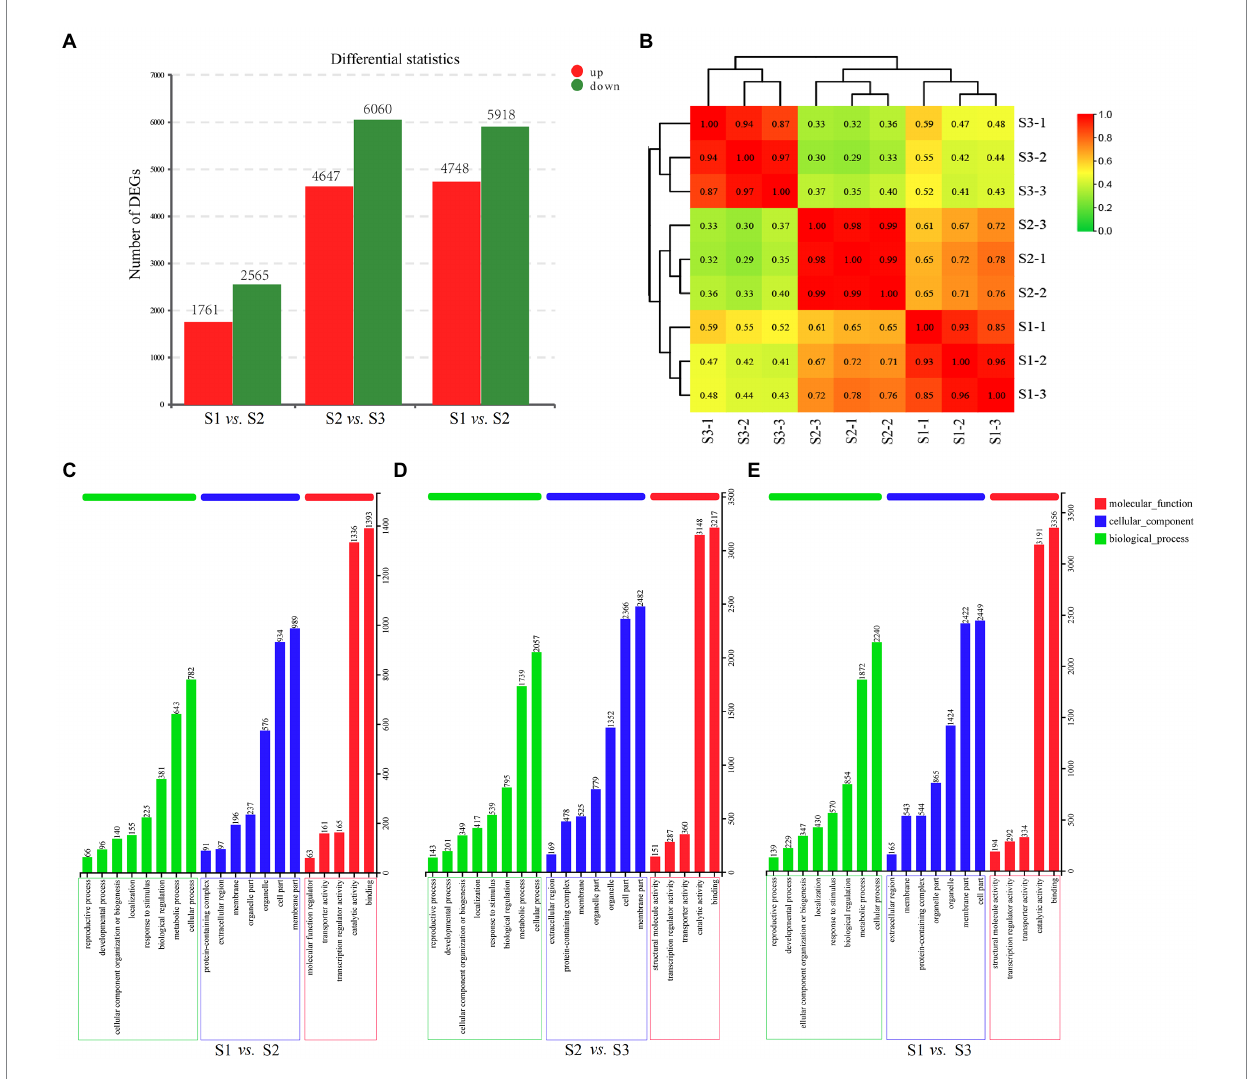
FIGURE 5 Transcriptome analysis for the fruits at the different developmental stages. (A) The number of DEGs in different comparison groups. (B) Relationship of RNA-seq. (C) GO enrichment analysis of DEGs in S1 vs. S2. (D) GO enrichment analysis of DEGs in S2 vs. S3. (E) GO enrichment analysis of DEGs in S1 vs.